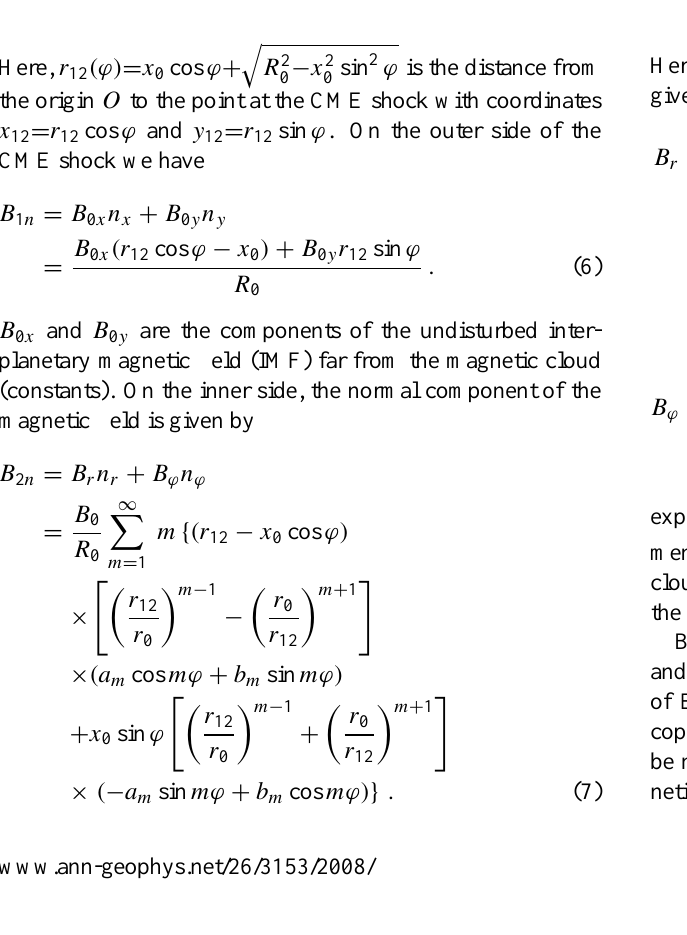
Fig. 2. Magnetic magnitude and components measured at 1AU on 20 November